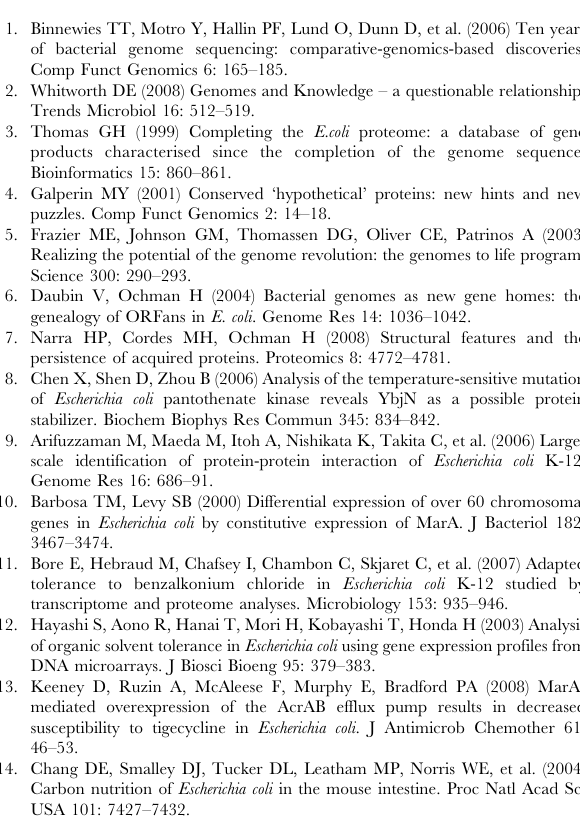
shown as underneath symbols. Gaps introduced for alignment are indicated by dashes (-). Table S1 YbjN homologues in Enterobacteriaceae that are pathogens or commensals. Table S2 Differentially expressed genes in ybjN mutant and over-expression strains compared to E. coli K-12 strain BW25113. Table S3 Amino acid and nucleotide biosynthetic genes that are suppressed in ybjN over-expression strain (p- value , 0.05). Table S4 Bacterial strains, plasmids and primers used in this